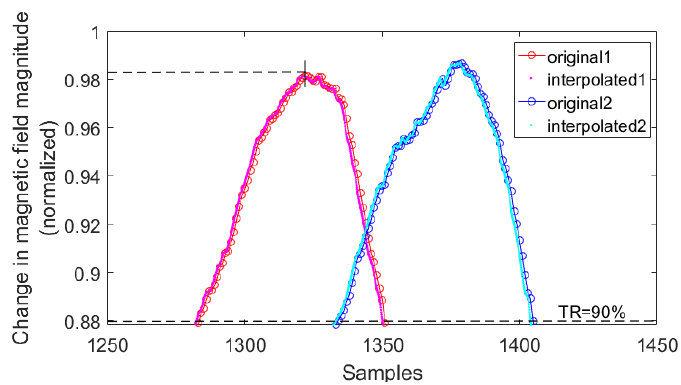
Figure 7. Original signals and signals interpolated with factor r = 10.